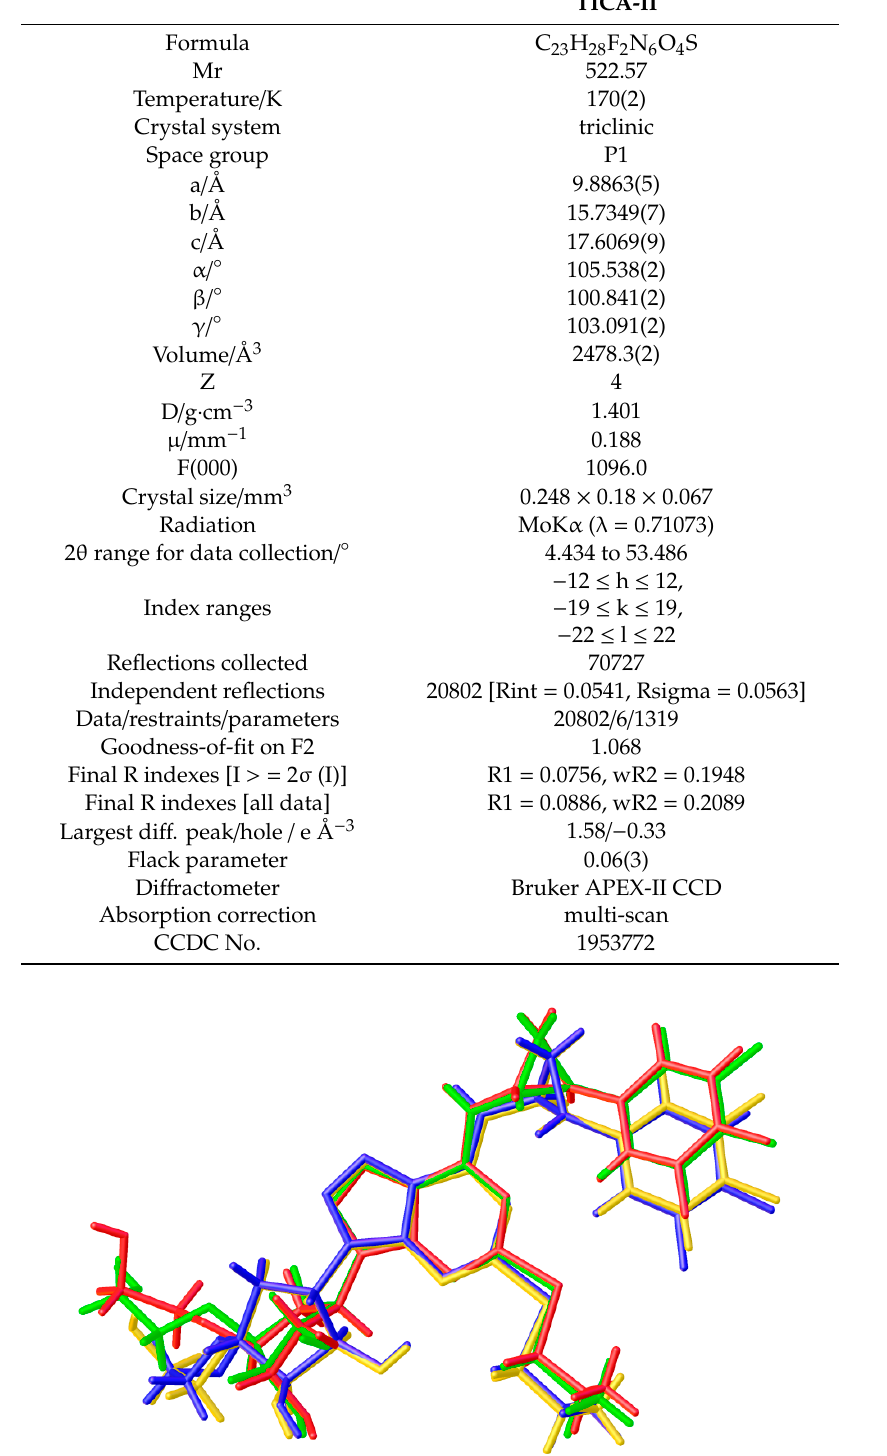
Table 1. Relevant crystallographic data details for TICA-II.